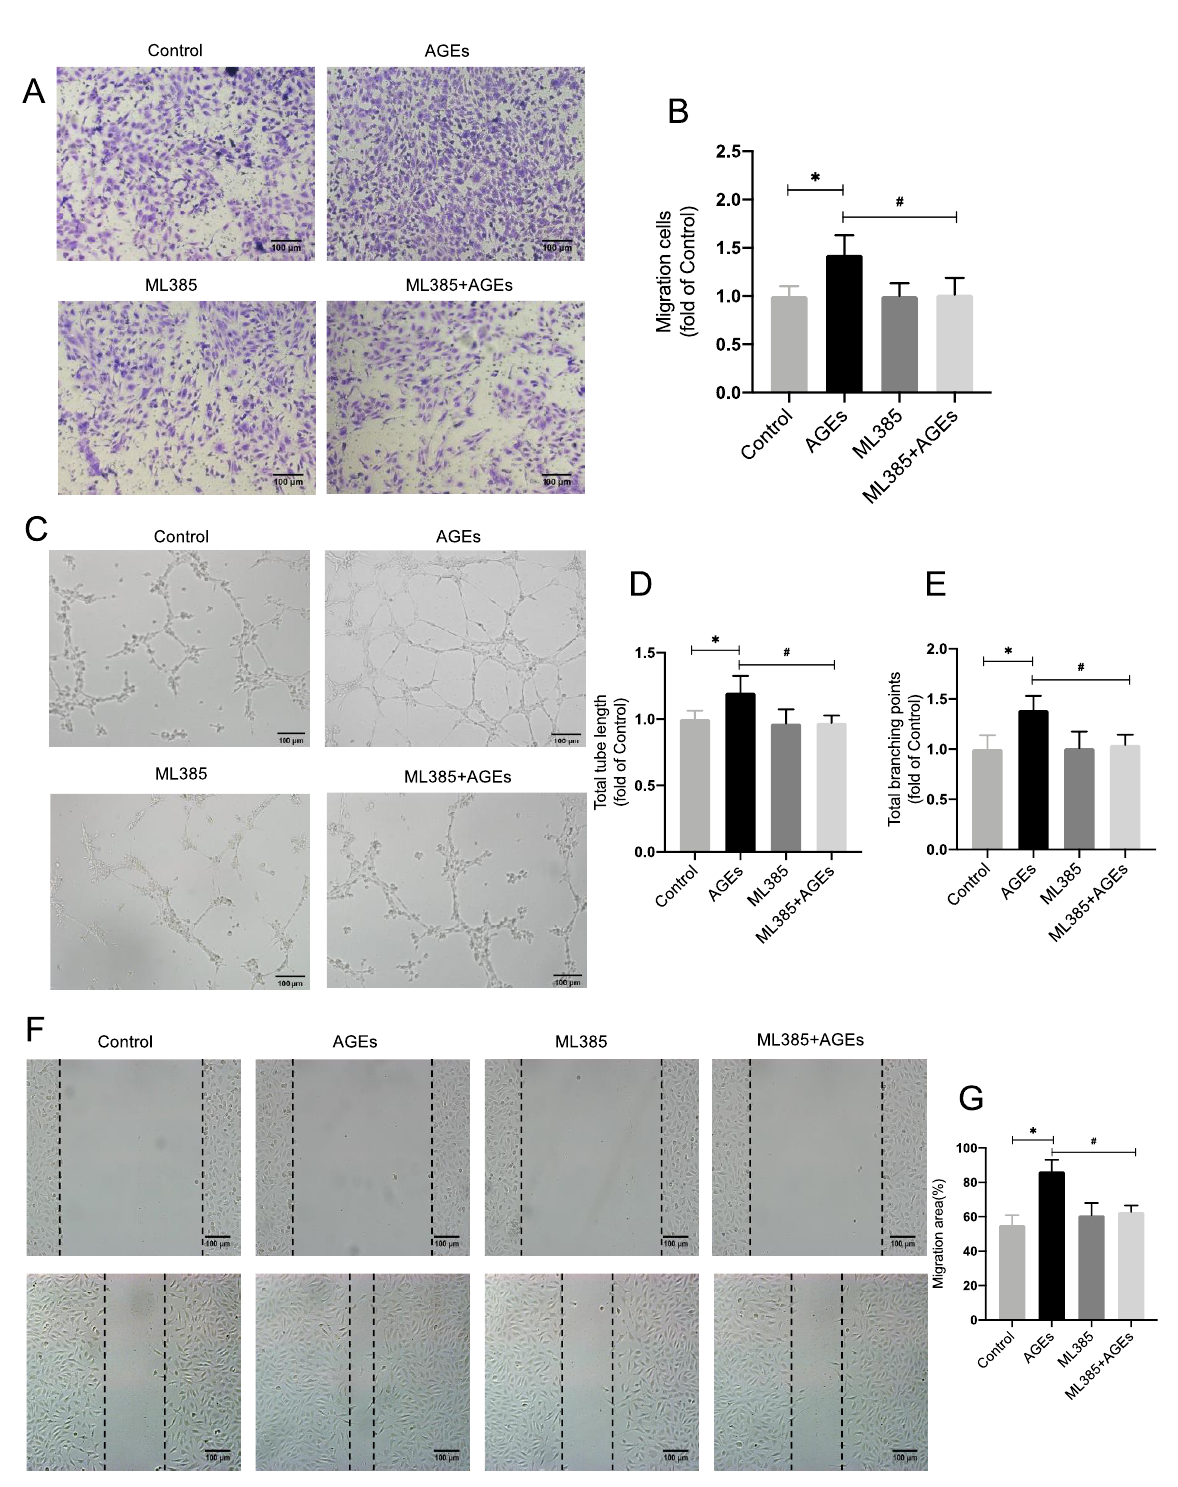
Figure 2. Inhibiting Nrf2 entry decreases AGE − induced angiogenesis. ( A , B ) Transwell migration assay, inhibition of Nrf2 nuclear translocation alleviated the endothelial migration caused by AGEs in HUVECs, n = 4, * p < 0.05 vs. control, # p < 0.05 vs. AGEs. Scale bar: 100 μm. ( C – E ) Inhibition of Nrf2 nuclear translocation alleviated the endothelial tube formation and lessened the total branching points caused by AGEs in HUVECs. n = 4, * p < 0.05 vs. control, # p < 0.05 vs. AGEs. Scale bar: 100 µ m. ( F , G ) Scratch wound healing, n = 6, * p < 0.05 vs. control, # p < 0.05 vs. AGEs. Scale bar: 100 µ m. * and # indicate significance between the indicated